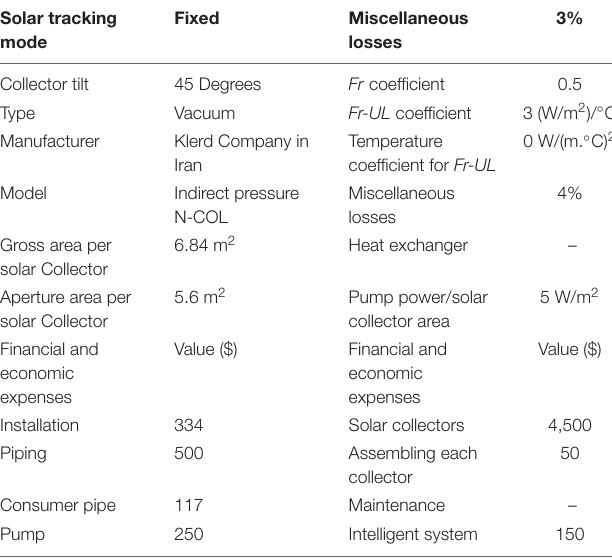
TABLE 4 | Technical and financial information regarding the collector.